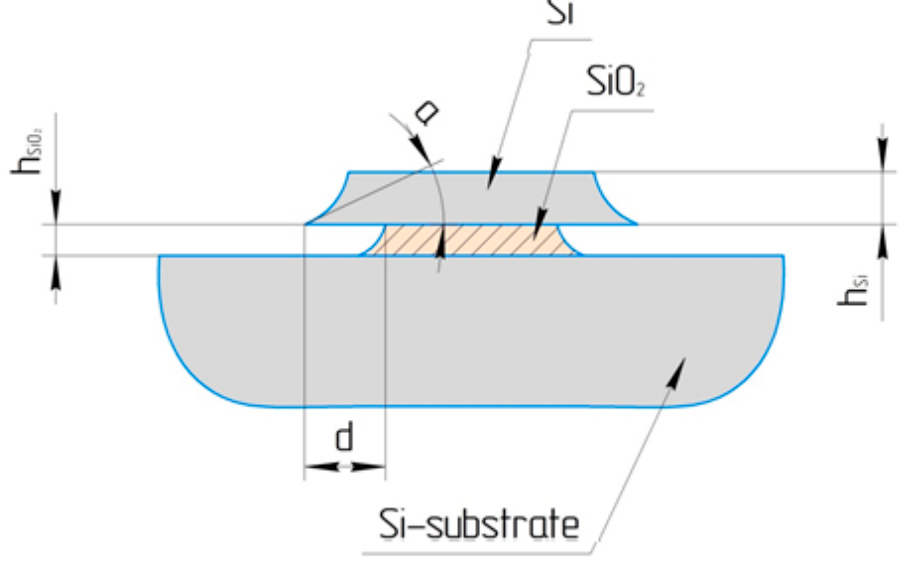
Figure 1. Schematic of the cross-section of the structure of a silicon whispering-gallery-mode (WGM) waveguide. Environment is air. h Si , the thickness (height) of the wedge-shaped waveguide; h SiO2 , thickness (height) of the dielectric layer; d, distance from the edge of the wedge to the beginning of the oxide beam (support); a, wedge angle.